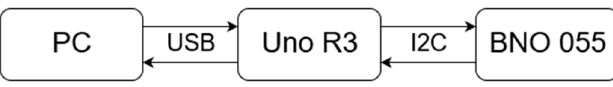
Figure 2. Data flow of the communication.